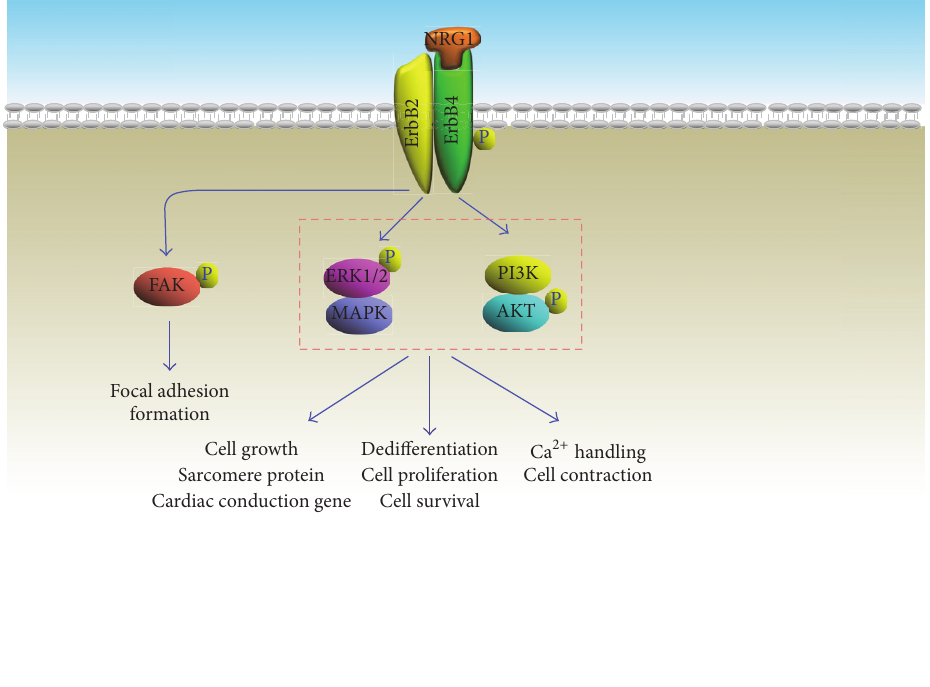
Figure 2: Signal pathways contributing to NRG1-induced cardiac regenerative